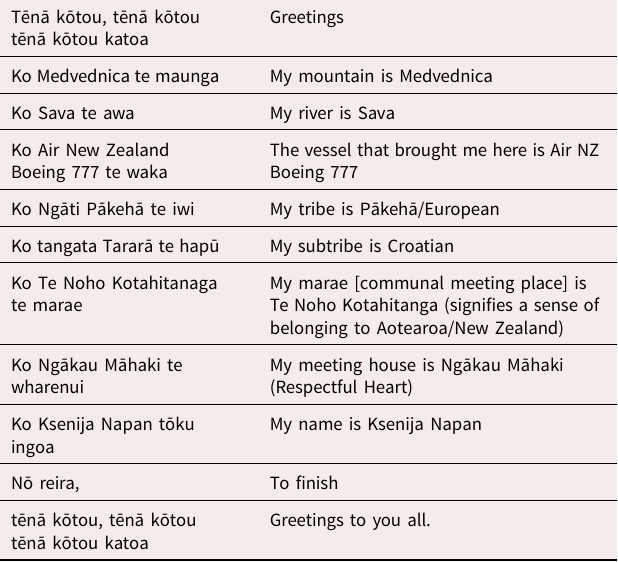
Table 3. Pepeha (M ā ori Device for Introducing the Self) of Ksenija Napan